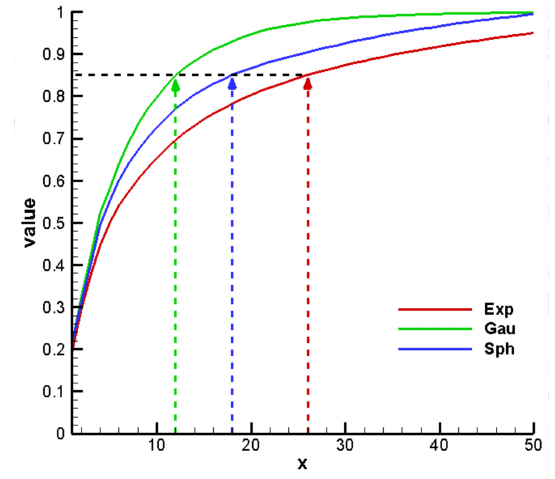
Figure 7. Reserved energy curves for three postulated